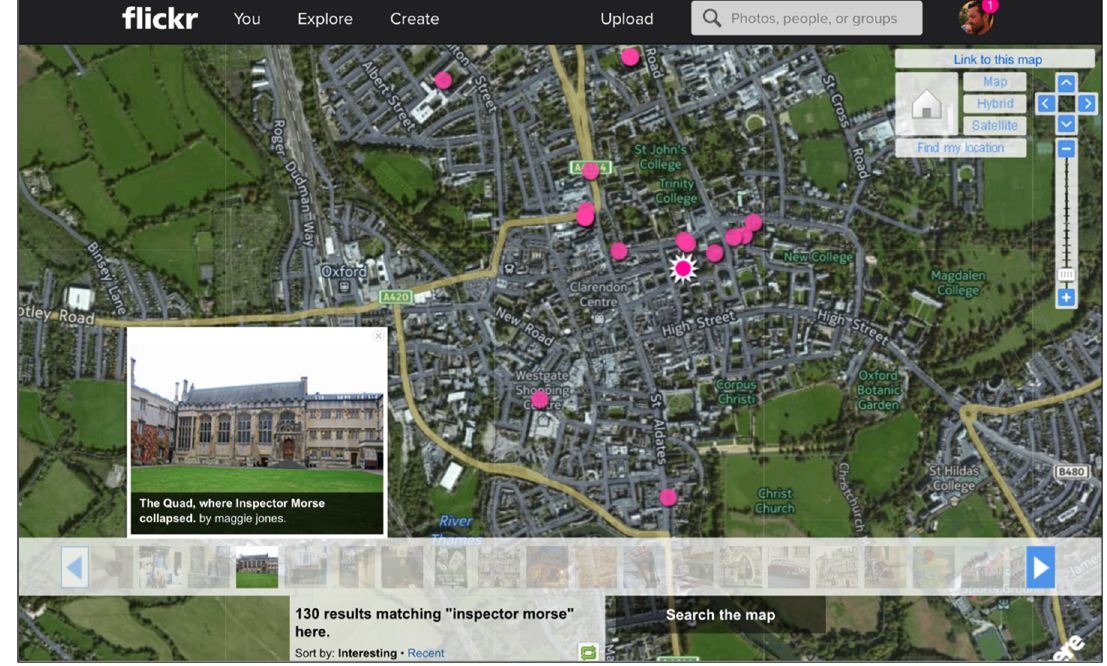
Figure 2. Flickr ’s searchable map of images uploaded in Oxford [19]. © 2012 Digital